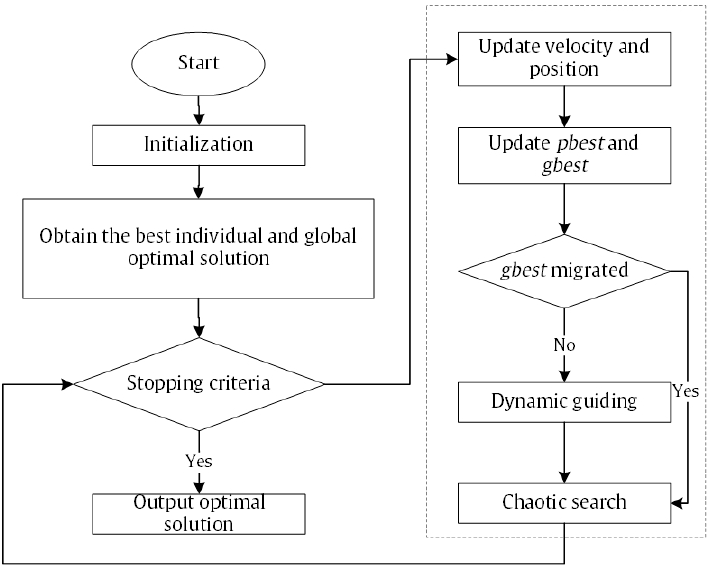
Figure 4. Flowchart of DCPSO.